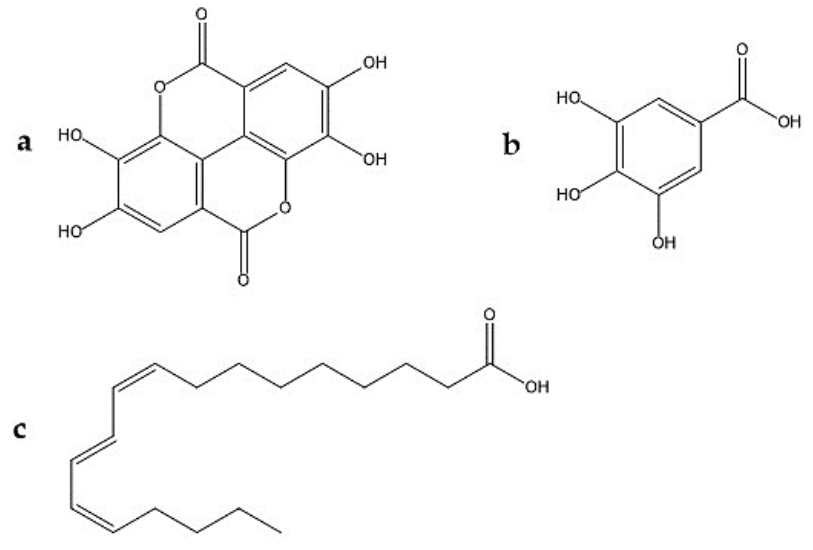
Figure 3. Chemical structures involved in the antinociceptive effect of Punica granatum L. ( a ) ellagic acid, ( b ) gallic acid, ( c ) punicic acid.